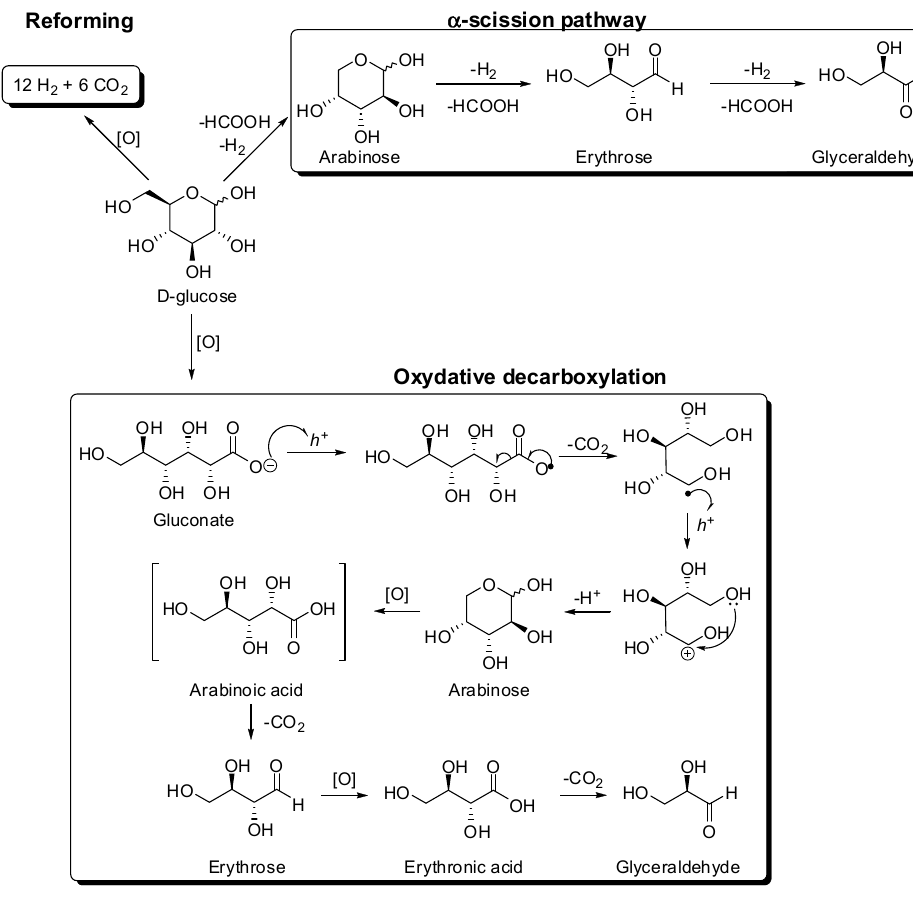
Scheme 3. Proposed mechanism accounting for the photocatalytic conversion of glucose under visible and UVA light illumination proposed by Da Vià et al. [36]. The pathway includes the α -scission hypothesis of Chong et al. [40] and Ruff degradation [41].